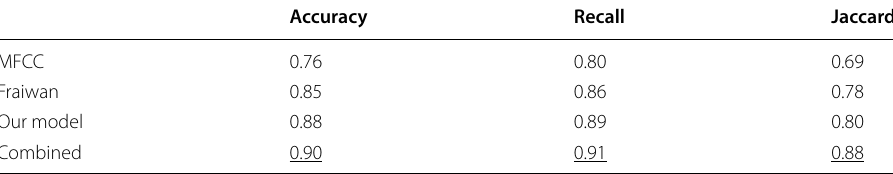
Table 1 Results obtained by means of the different models in the multi-class task of classifying lung sounds Accuracy